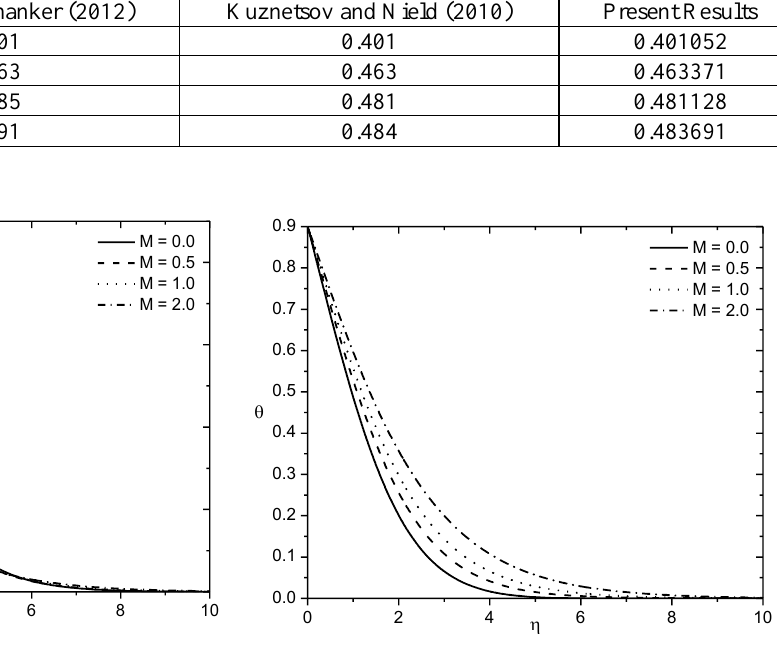
Figure 1. Effet of M on the Velocity Figure 2. Effet of M on the Temperature